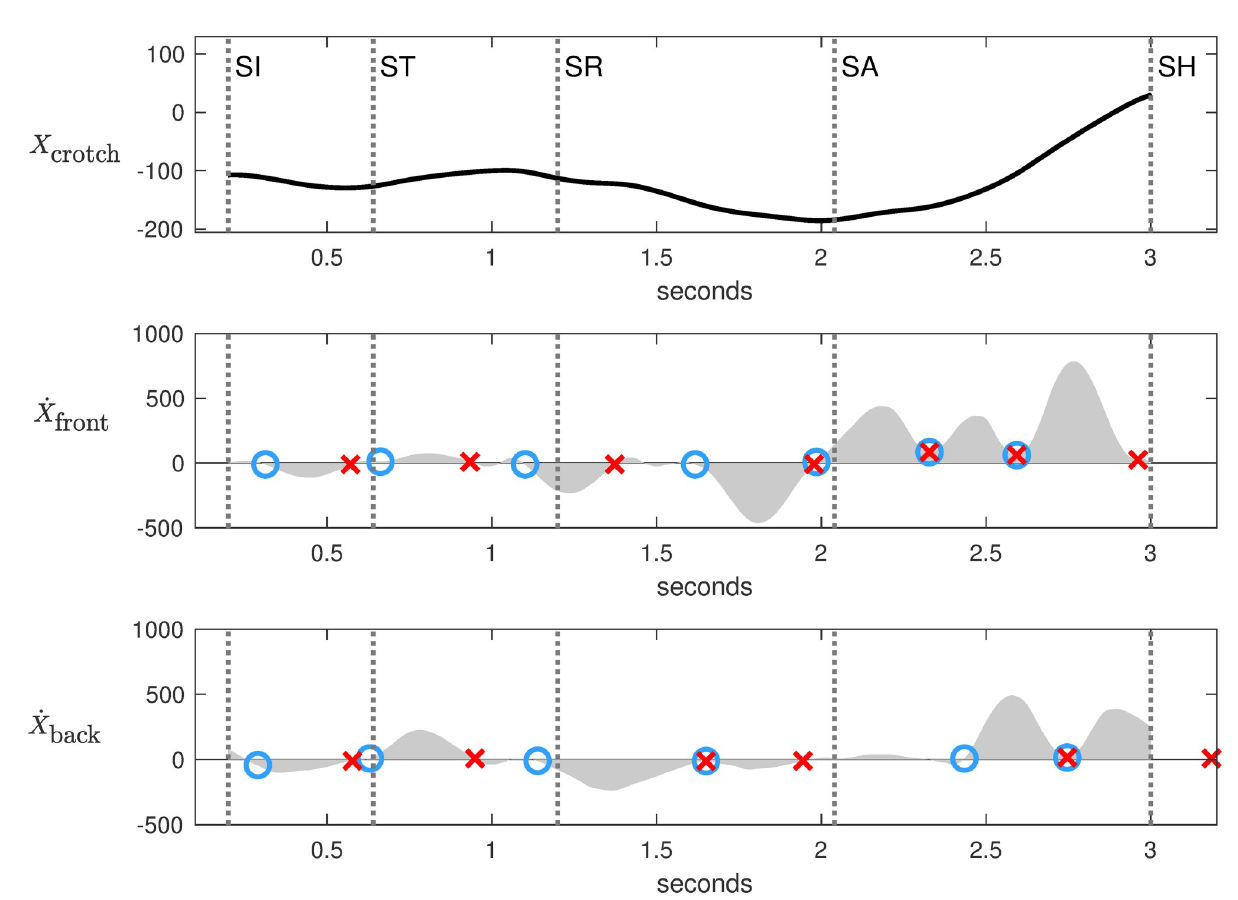
Fig 8. Footwork analysis of Steffen. X crotch is horizontal position of the crotch. _ X of the back foot. Each step corresponds to a velocity bump (gray area) delimited between a blue circle and a red cross.